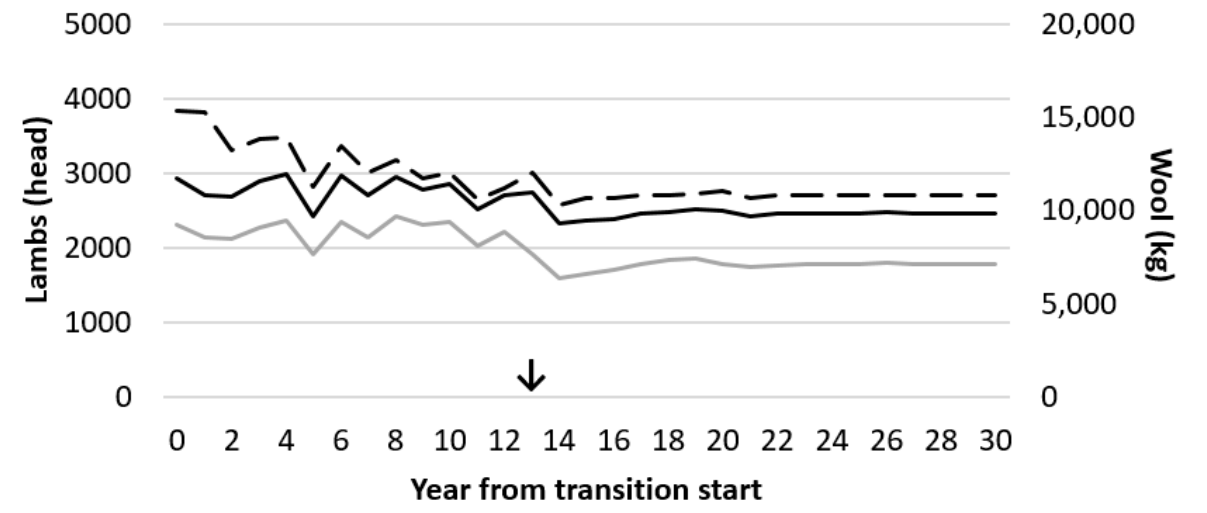
Figure 5. Numbers of lambs weaned, lambs sold, and wool sold (right hand side y axis) during a grading up transition. ↓ indicates where the ¾Merino¼Romney flock has reached the same annual feed demand as the base Romney flock.